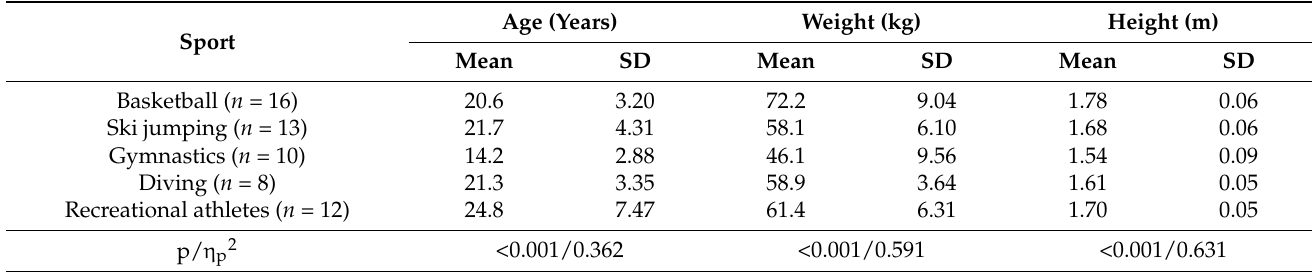
Table 1. Anthropometrics (mean ± standard deviation) of subjects in relation to different sports.